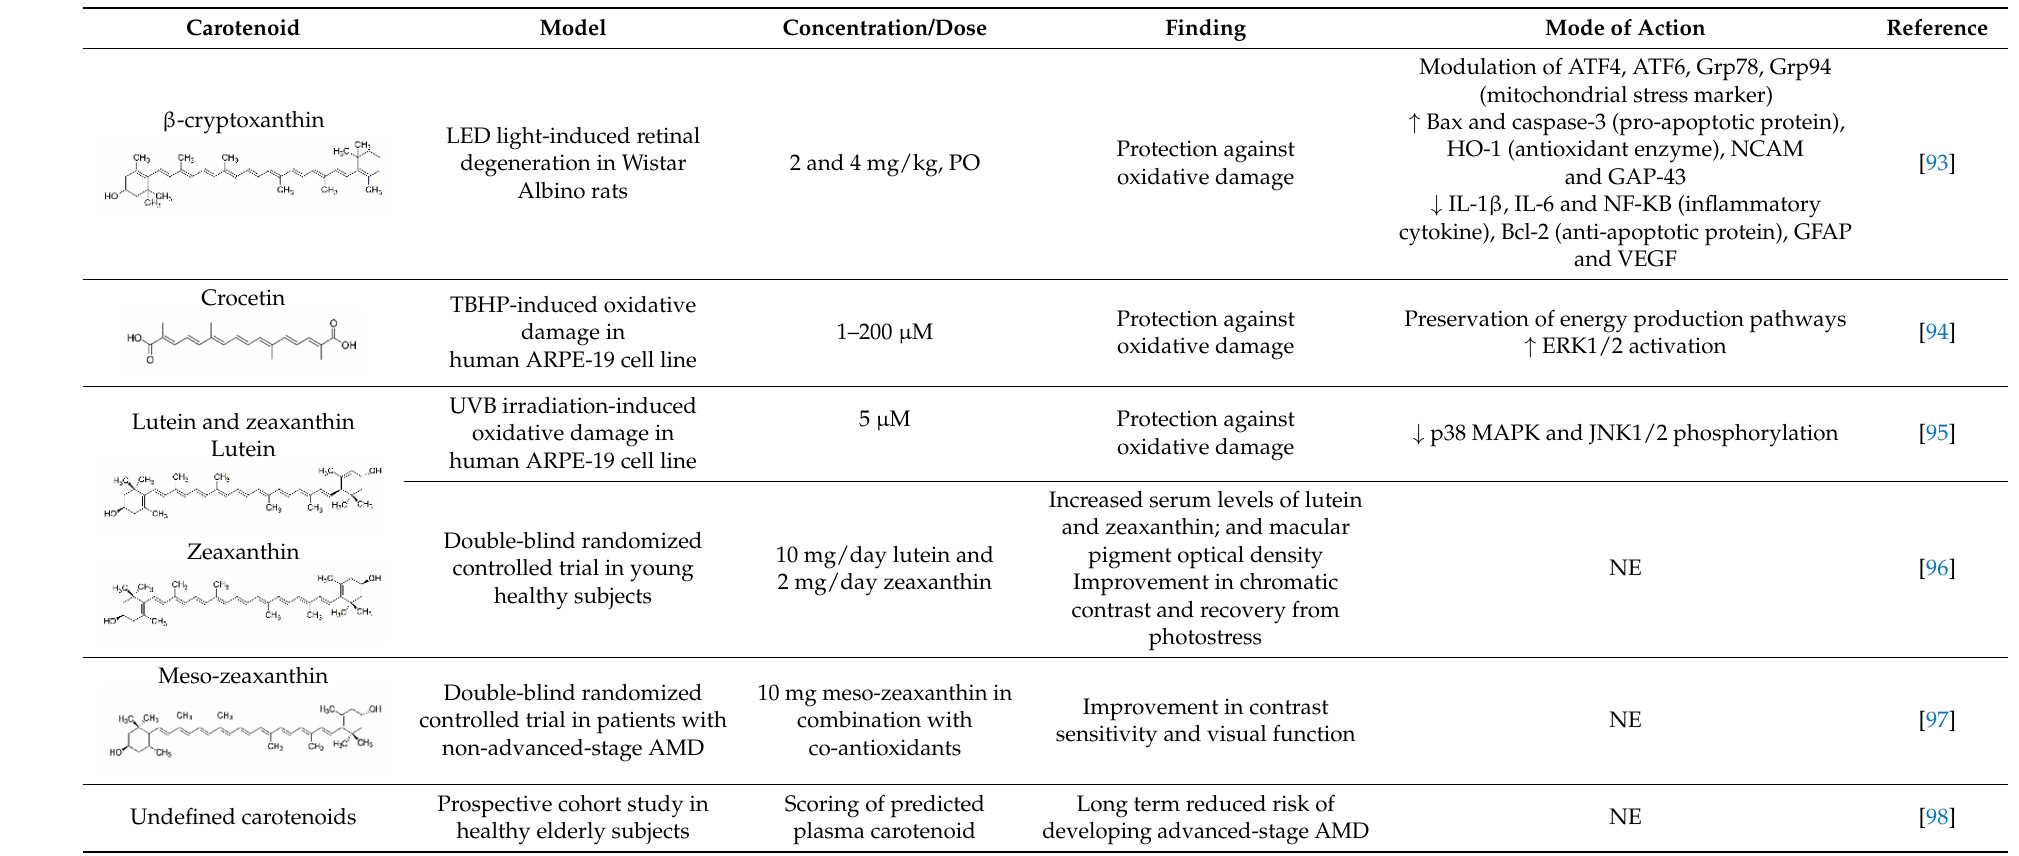
Table 2. Carotenoids in the alleviation of